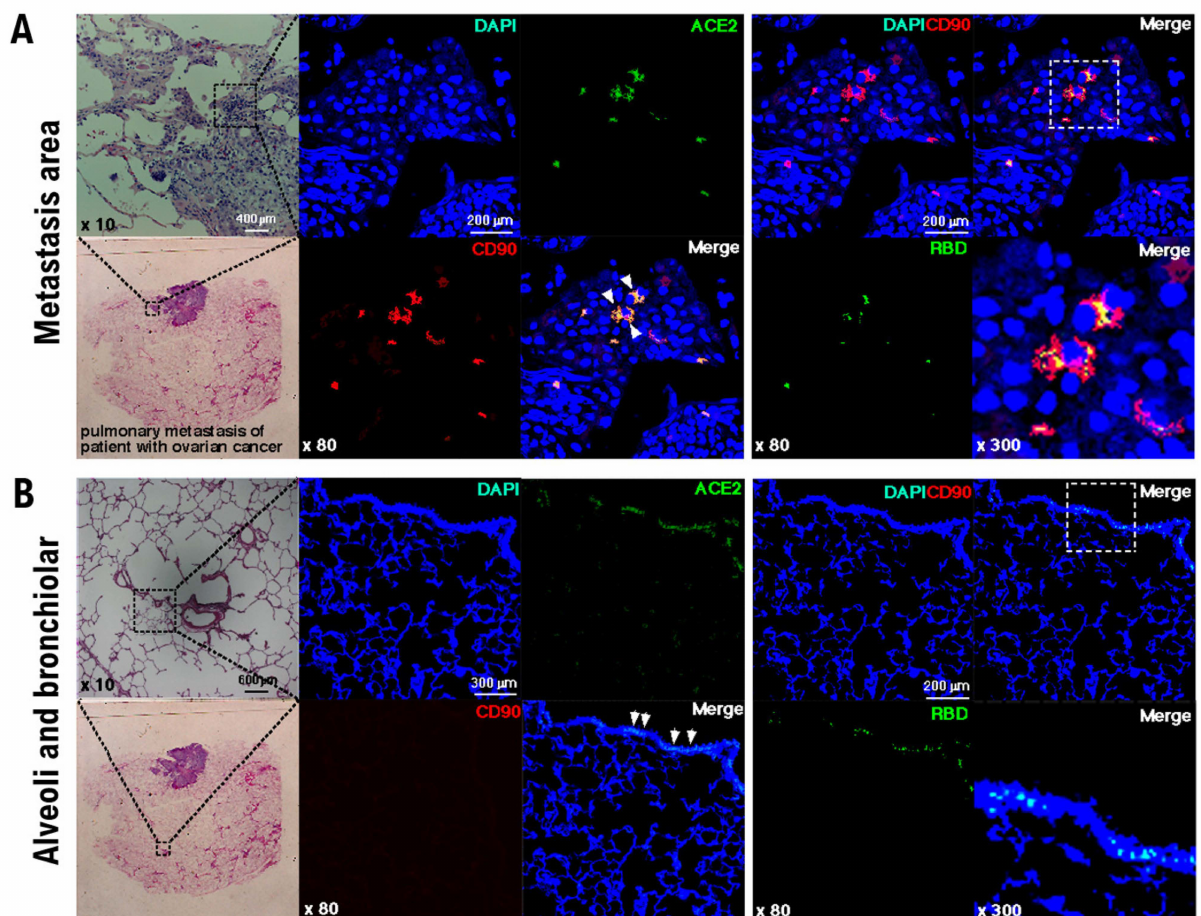
Figure 1. Binding of the RBD of the SARS-CoV-2 spike glycoprotein to the stem-like cells in normal neighboring alveolar epithelial cells. Immunohistochemical studies were performed using pulmonary metastatic tissue surgically excised from patients with high-grade serous ovarian carcinoma. The expression levels of CD90 and ACE2 and the binding of RBD in the normal alveolar and bronchiolar areas as well as in the metastases were investigated by pathological studies. In the photographs of the metastases ( A ) and normal alveolar and bronchiolar areas ( B ), the expression of each factor and binding activity are indicated by fluorescent color. Human ACE2-positive (green) and CD90-positive (red) stem-like cells, indicated by white arrowheads in human normal neighboring alveolar epithelial cells, were found in pulmonary micrometastases. Human CD90-positive cells (red) were not detected in the metastatic colonies of human serous ovarian carcinoma. Immunohistochemical studies were performed using an antibody recognizing human ACE2 (green), a monoclonal antibody detecting the spike glycoprotein of SARS-CoV-2 (green), and an antibody specific for human CD90 (red), which is a biomarker for stem-like cells. The binding of the RBD of SARS-CoV-2 spike glycoprotein (green) to CD90-positive (red) alveolar epithelial stem-like cells was observed and is indicated in yellow. Anti-human CD90 (Abcam ab133350), anti-human ACE2 (ORIGENE, Rockville, MD, USA), and anti-spike glycoprotein of SARS-CoV-2 (GeneTex, Inc., Irvine, CA, USA) antibodies, as well as recombinant spike glycoprotein of SARS-CoV-2 protein (BioVision, Milpitas, CA, USA), were used. The experiments were performed five times with similar